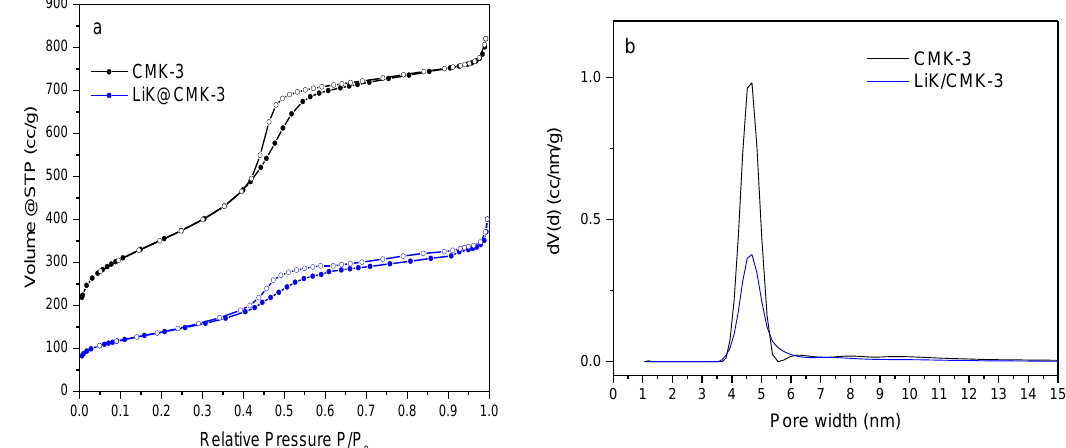
Figure 2. ( a ). N 2 adsorption / desorption isotherms at 77 K on the pristine CMK-3 carbon (black) and on LiK / CMK-3 composite (blue). ( b ). Pore size distribution of CMK-3 carbon (black) and LiK / CMK-3 composite (blue).